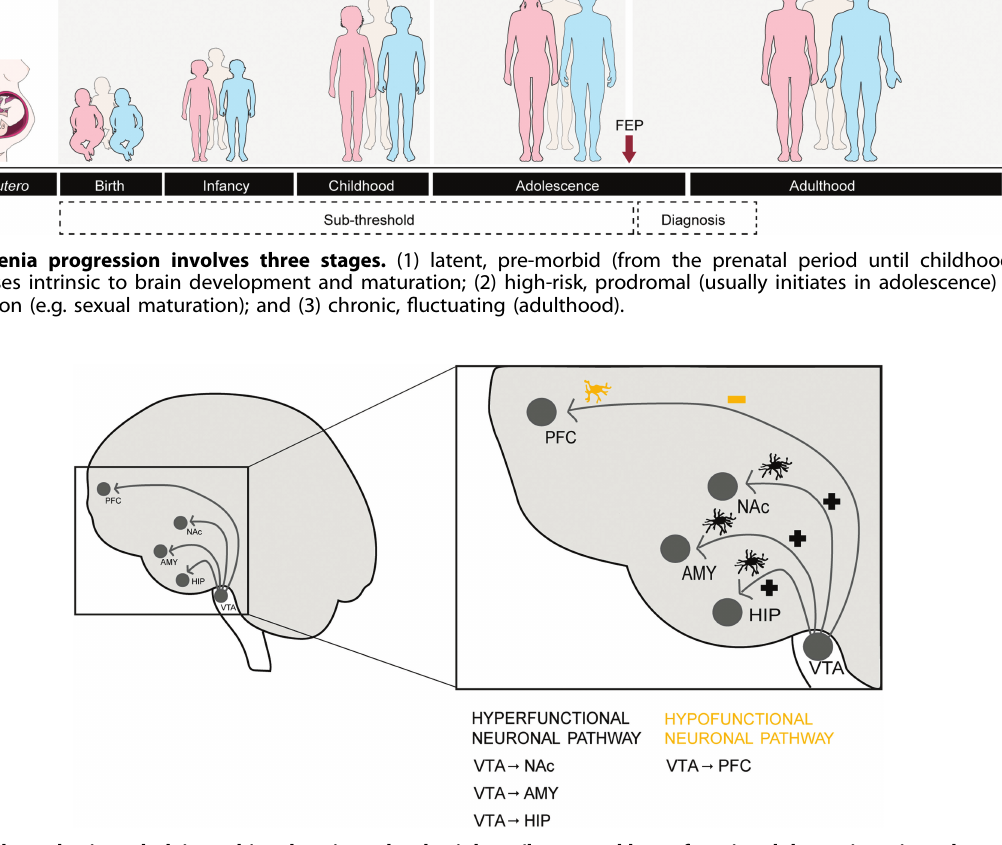
Fig. 2 Dopamine hypothesis underlying schizophrenia pathophysiology (hypo- and hyperfunctional dopaminergic pathways). Schematic representation of hypofunctional (decreased dopamine transmission to the prefrontal cortex (PFC)) and hyperfunctional (increased dopamine transmission to nucleus accumbens (NAc), amygdala (AMY) and hippocampus